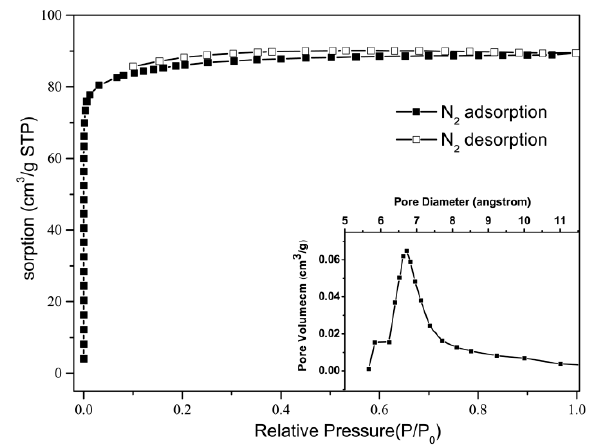
Figure 3. N 2 sorption isotherms of Zn(hfipbb) at 77 K (insert: the pore width distribution).